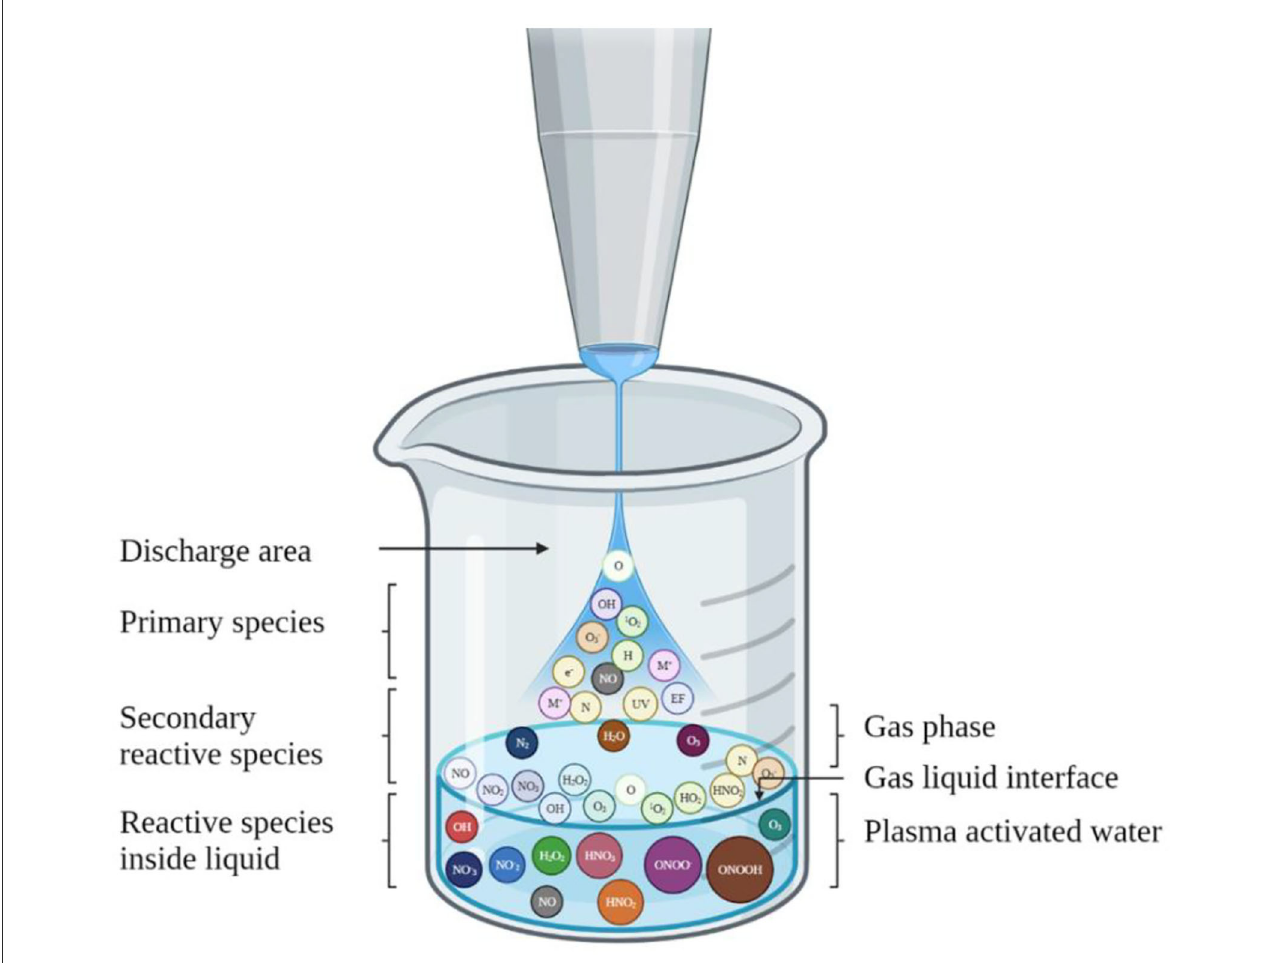
FIGURE3 A schematic diagram of the formation of plasma active water via a conventional plasma